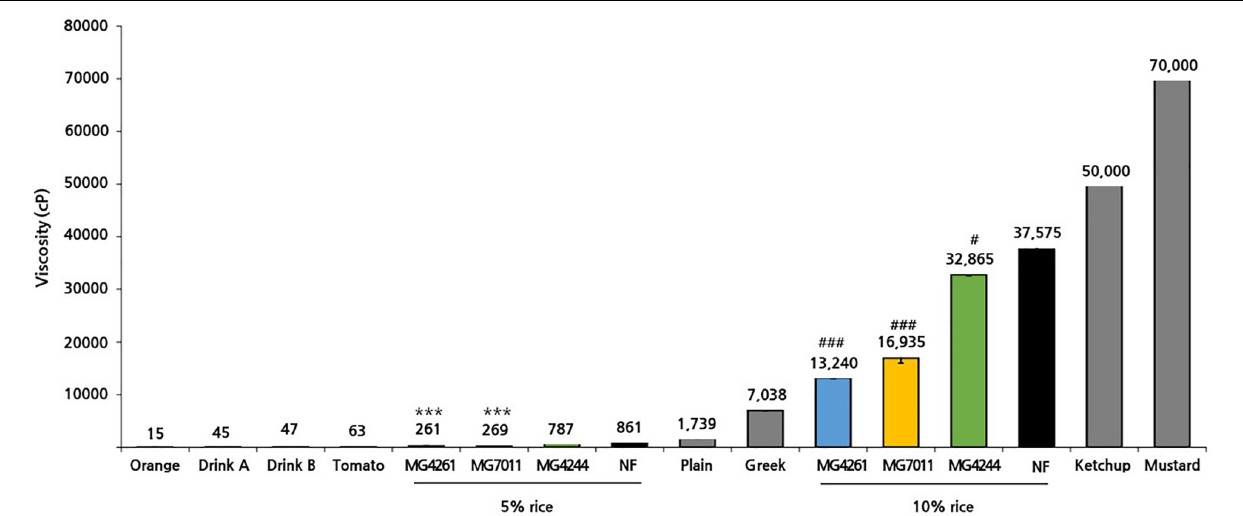
FIGURE 7 | Viscosity of rice solution fermented by Limosilactobacillus fermentum strains. Viscosities of fermented rice yogurt and commercial products were measured at 17 ◦ C. Results are expressed as means ± SD ( n = 3). There were significant differences compared with 5% non-fermented rice (NF; *** p < 0.001) and 10% non-fermented rice (NF; # p < 0.05, ### p < 0.001). For comparison, commercial products such as fruit juice (orange, tomato), drinking yogurt (product A, product B), and semi-solid yogurt (plain, Greek) were analyzed